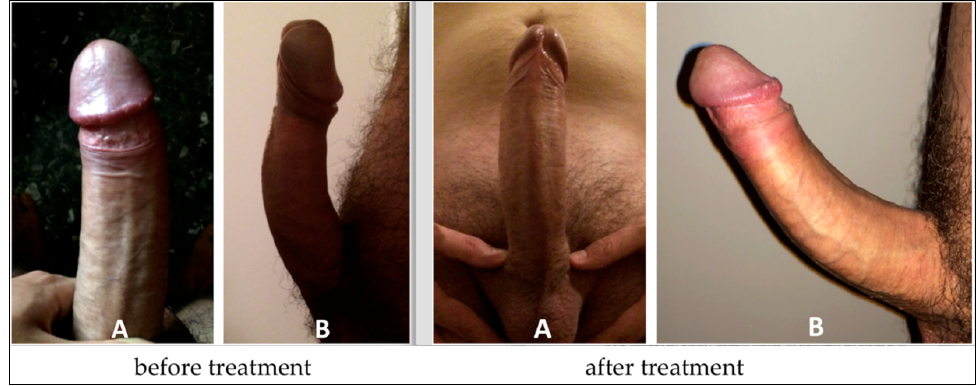
Figure 1. Case 1. Anterior ( A ) and lateral ( B ) photographic poses (before and after treatment). Upon physical examination, a fibrous nodule measuring approximately 10 mm was palpable at the distal third of the penis.